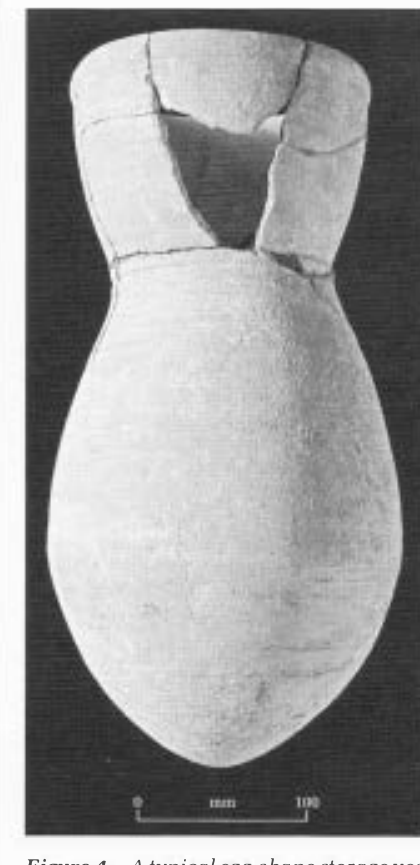
A typical egg-shape storage ves­ sel of the type also used as a reaction vessel for glassmaking.